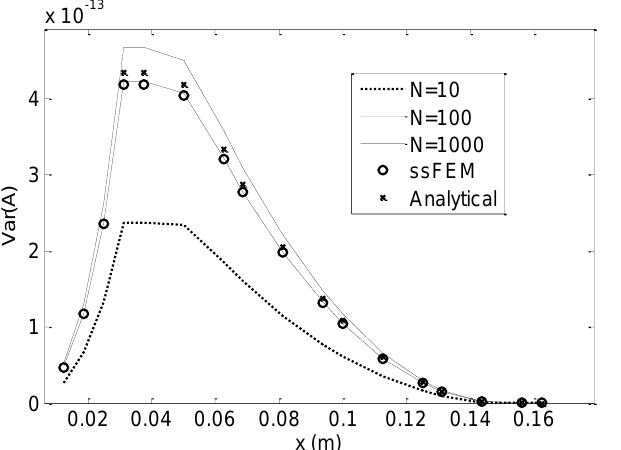
Fig. 3. Variances at (x, 0.05) obtained with different Monte-Carlo simulations, ssFEM and analytically. Fig. 4. Variance convergence with